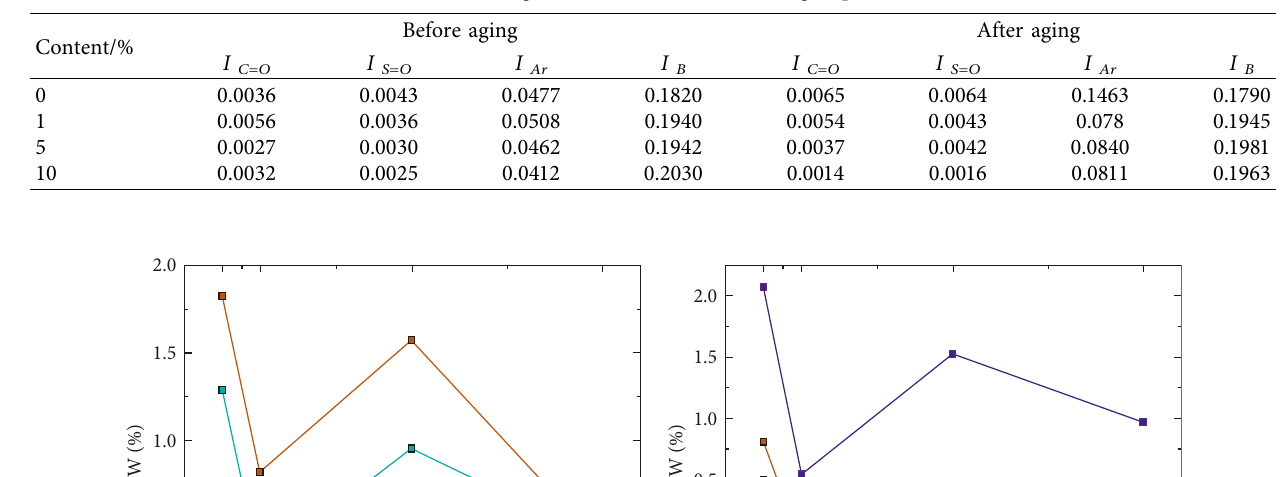
Table 7: Effect of Irganox 1010 on the functional group index of